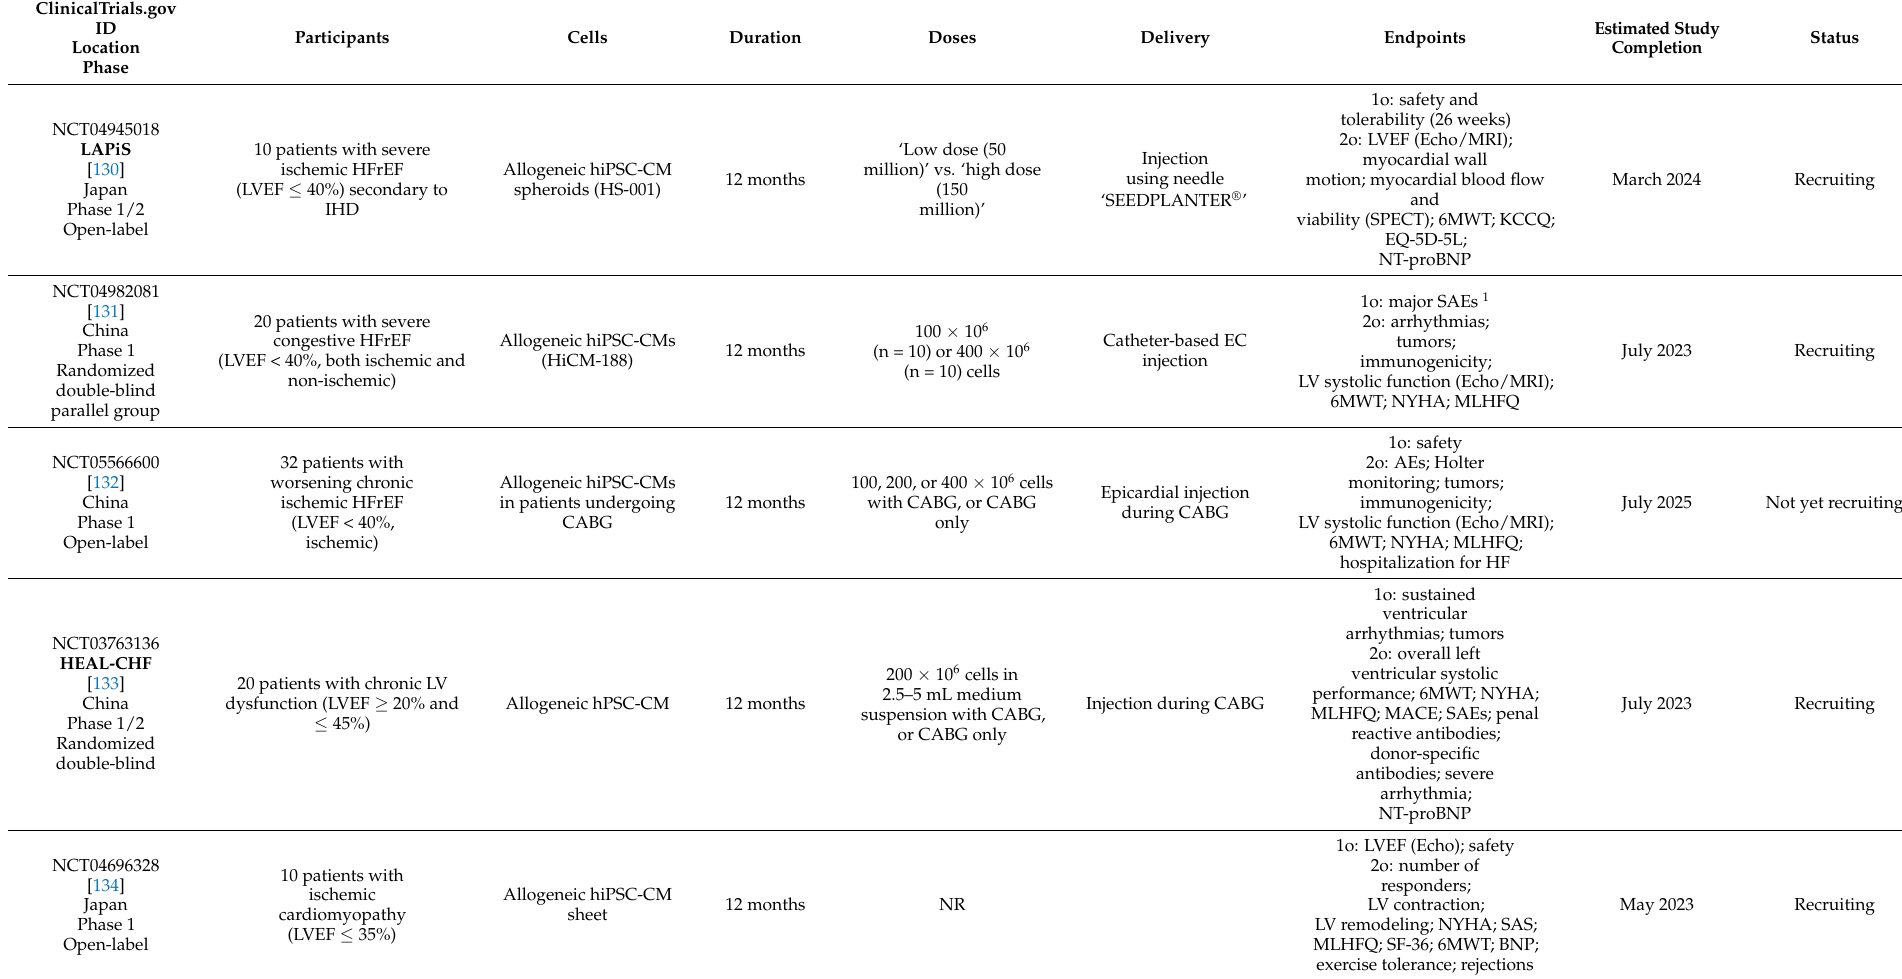
Table 3. Ongoing clinical trials of hPSC-CM-derived therapies in